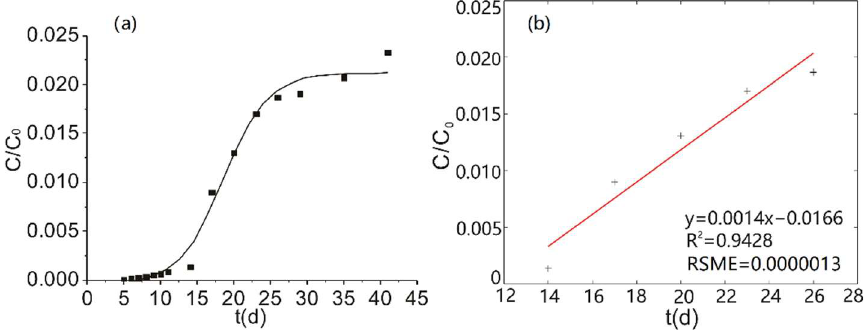
Figure 3. Diffusion curve of uranium on B 7 AP integrated buffer materials. ( a ) Diffusion curves of uranium. ( b ) The fitting line of uranium diffusion